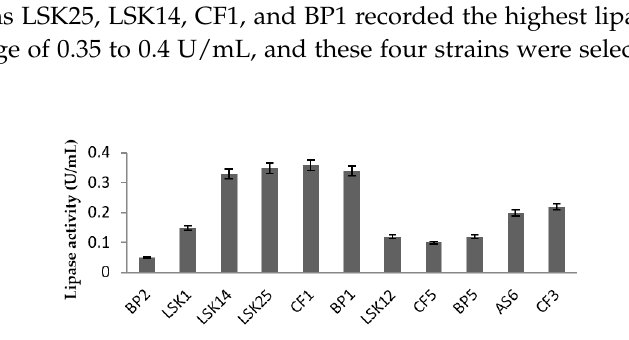
Figure 1. ( a ) Lipolytic activity clearing zone on tributyrin agar; ( b ) lipolytic activity on Rhodamine